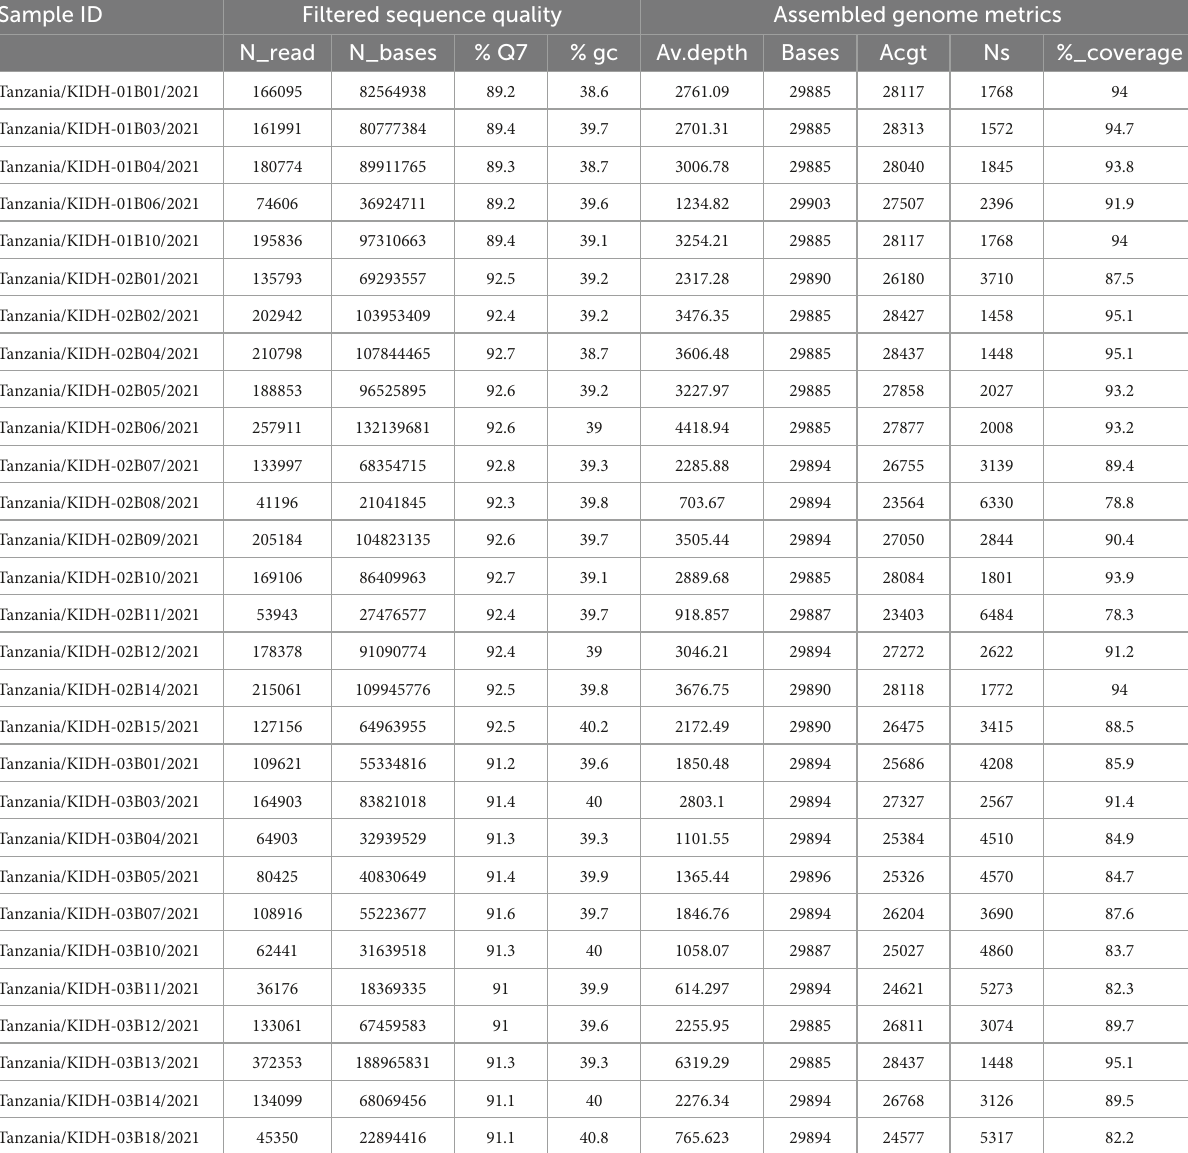
TABLE 1 Quality of sequence reads and metrics of assembled